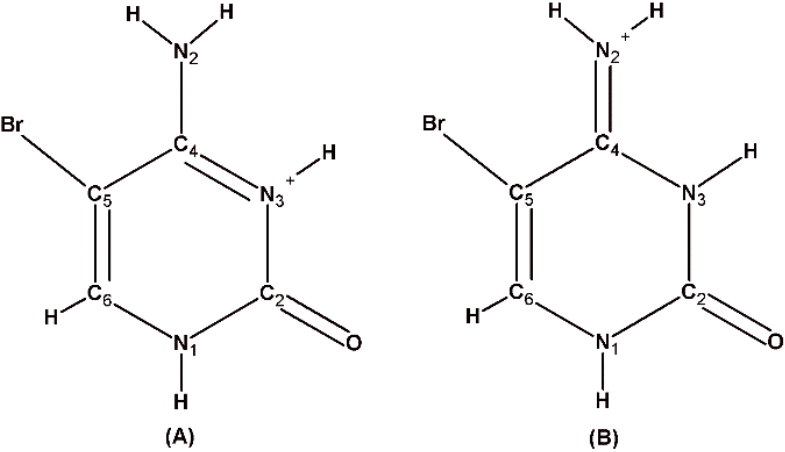
Figure 11. Two possible canonical forms ( A , B ) for 5-bromocytosinium cations in compounds ( I – VI